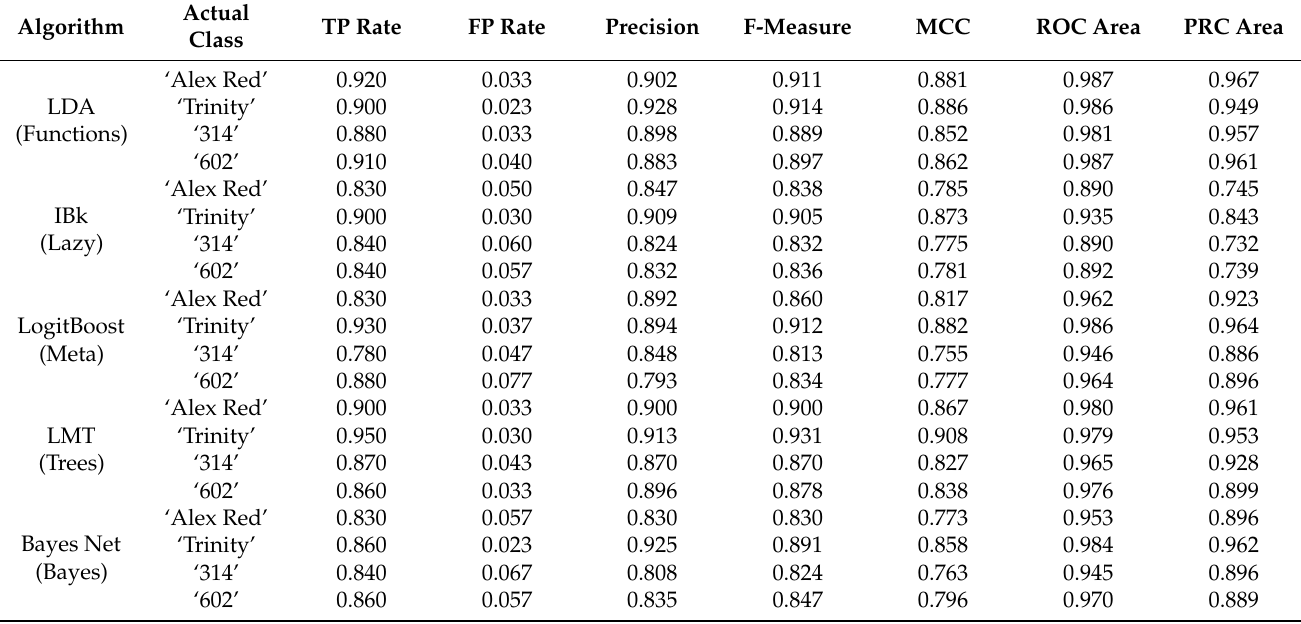
Table 3. The results of distinguishing freeze-dried red-fleshed apple slices based on features selected from a set of image texture parameters.